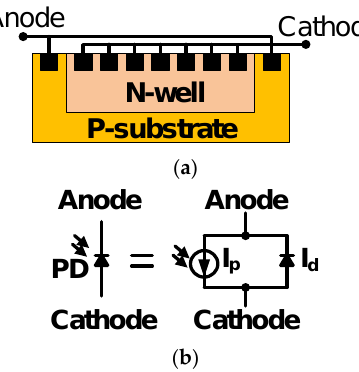
Figure 2. n+/p-substrate PD: ( a ) cross-section; and ( b ) the equivalent circuit.